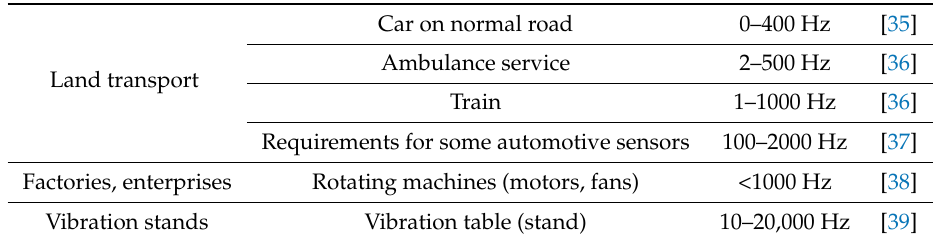
Table 2. Vibration frequency band for general applications.